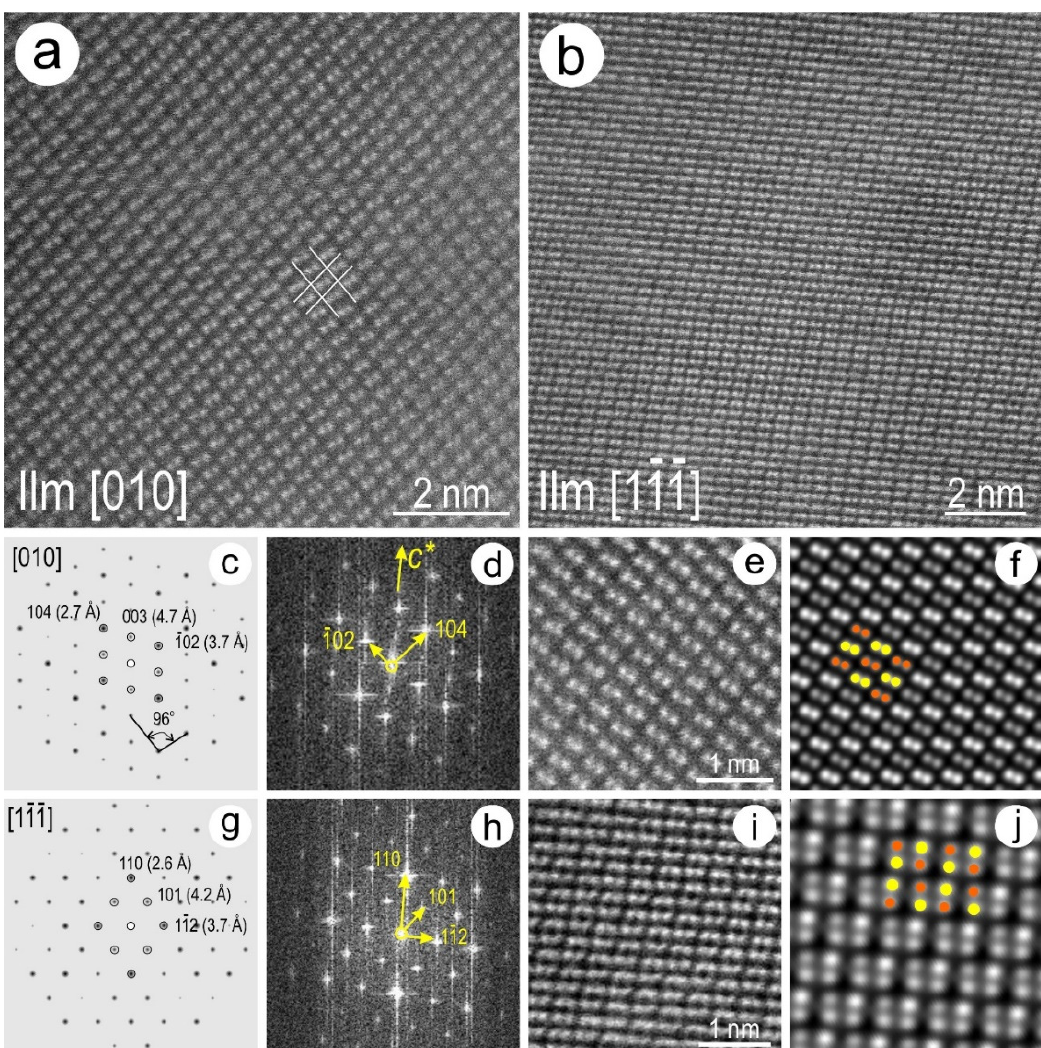
Figure 11. ( a , b ) High-resolution HAADF STEM images showing ilmenite on zone axes, as marked. The four panels ( c – f , g – j ) show, from left to right: indexed electron diffraction simulation, FFT, HAADF STEM image, and STEM simulation for [010] ( c – f ) and ( g – j ) (cid:4670)11(cid:3364)1(cid:3364)(cid:4671) zone axes, respectively. Overlays of atoms obtained from crystal structure models for ilmenite using crystallographic data from [43] on the STEM simulations are yellow (Fe) and orange (Ti).